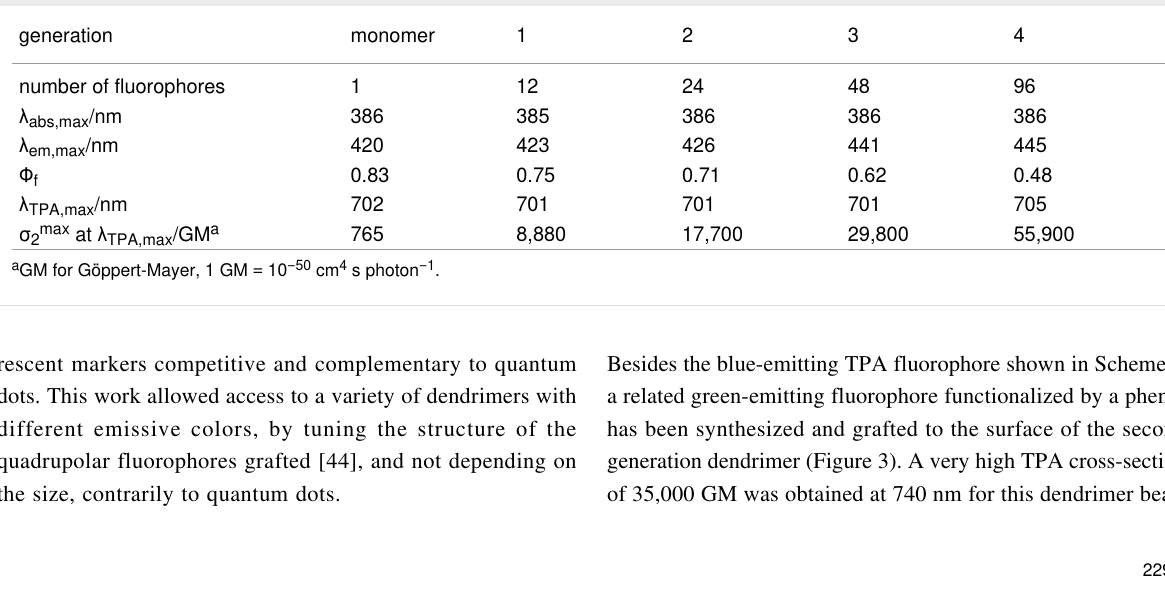
Table 1: Photophysical properties of the types of dendrimers shown in Scheme 2 (measured in toluene). generation